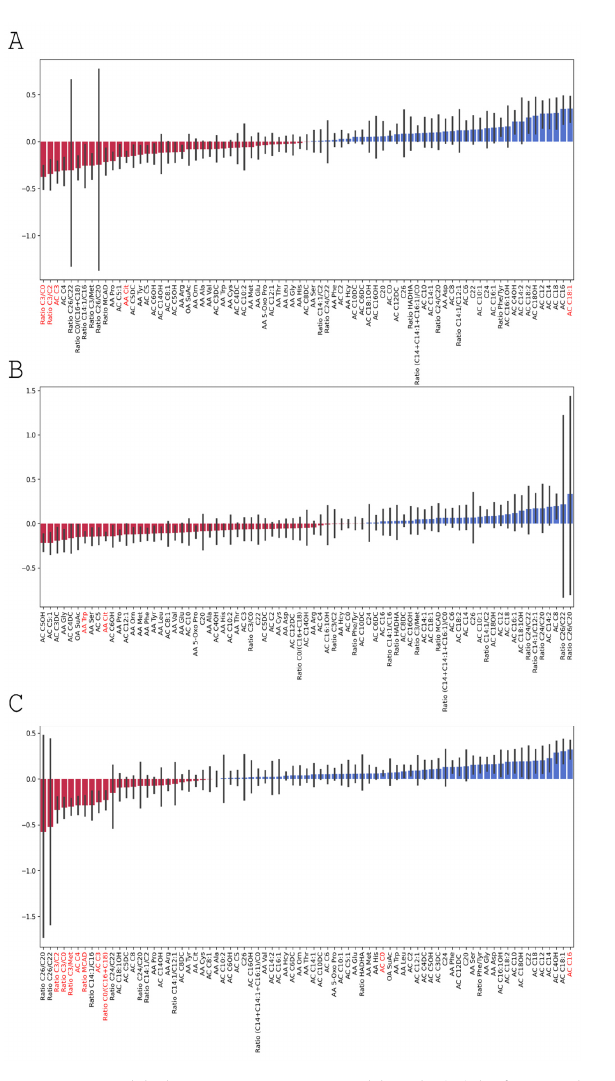
Figure 10. Fold changes in amino acid levels ( A ) before and on day 7 after the TBI; ( B ) before and on day 3 after the TBI; ( C ) on days 3 and 7 after the TBI. Significant results are shown in